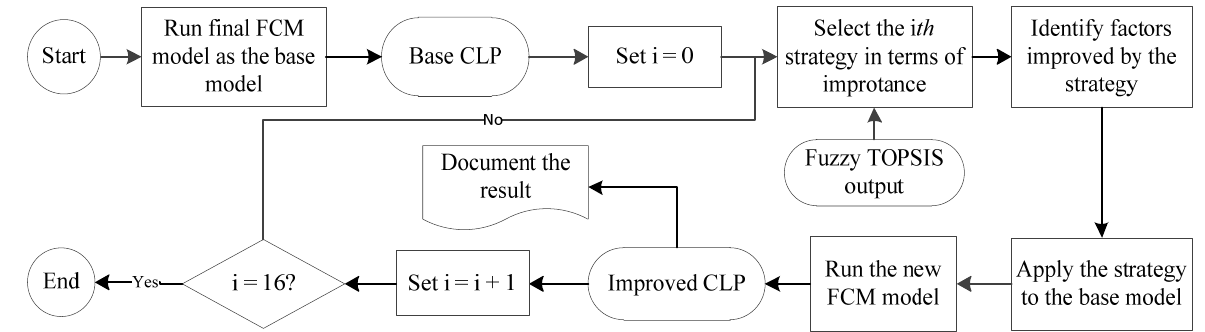
Figure 7. FCM model of CLP with refined optimal weights.